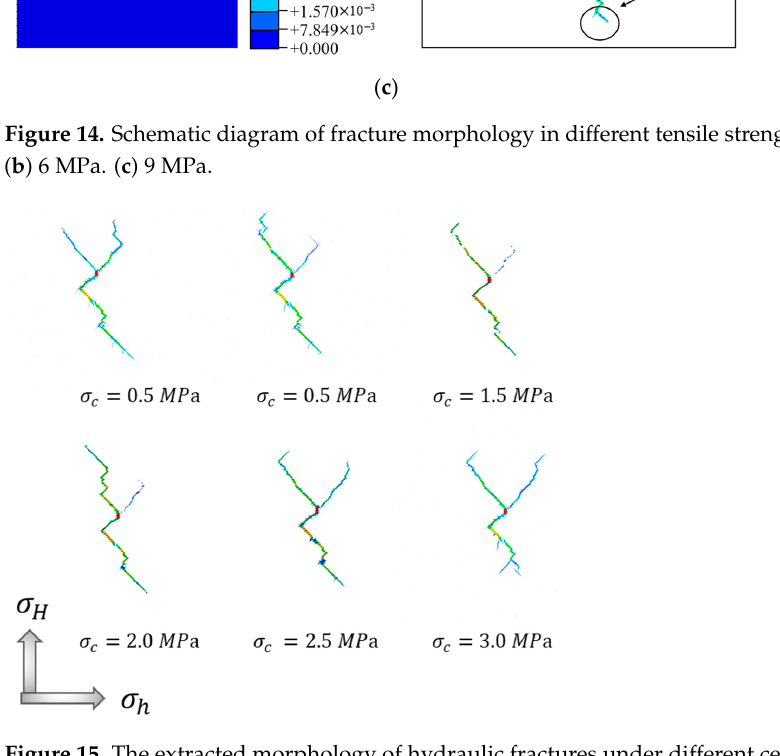
Figure 15. The extracted morphology of hydraulic fractures under different cementing strengths of natural fractures.